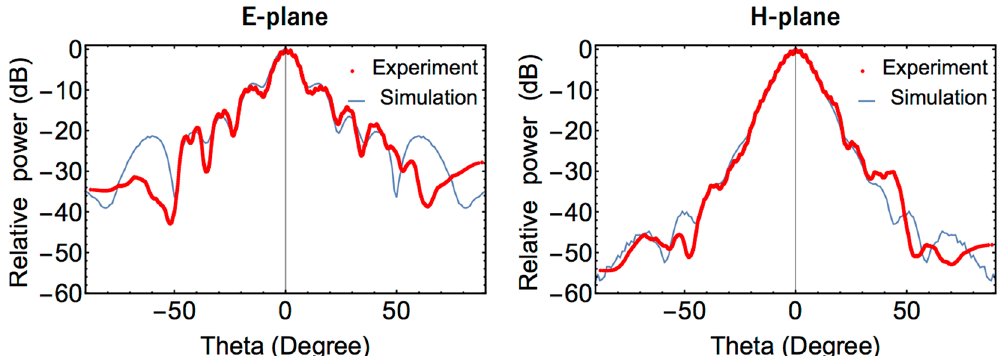
Figure 5. Radiation patterns of the horn antenna calculated from the measured